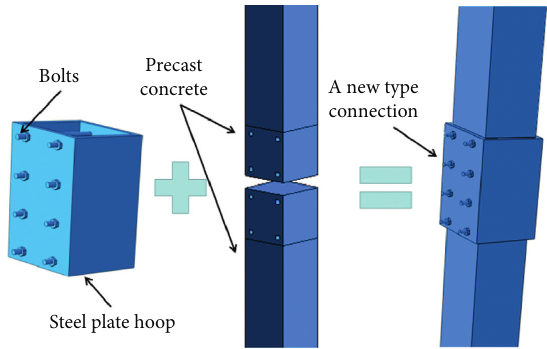
Figure 1: Steel tube with bolts